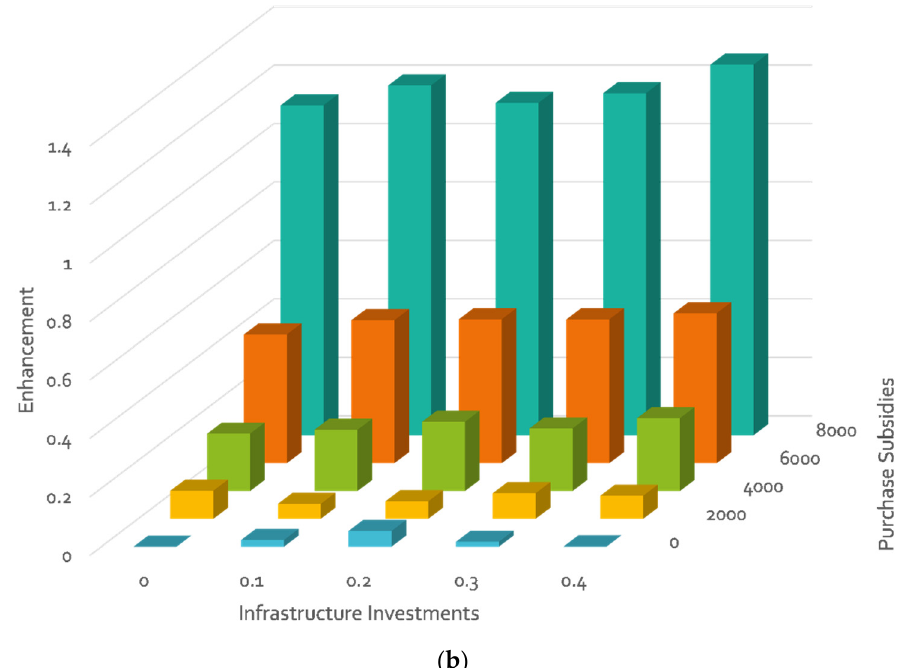
Figure 8. Results for different incentive constellations in 2025: ( a ) no rise in fuel prices; ( b ) rise in fuel-price of 20 cents.